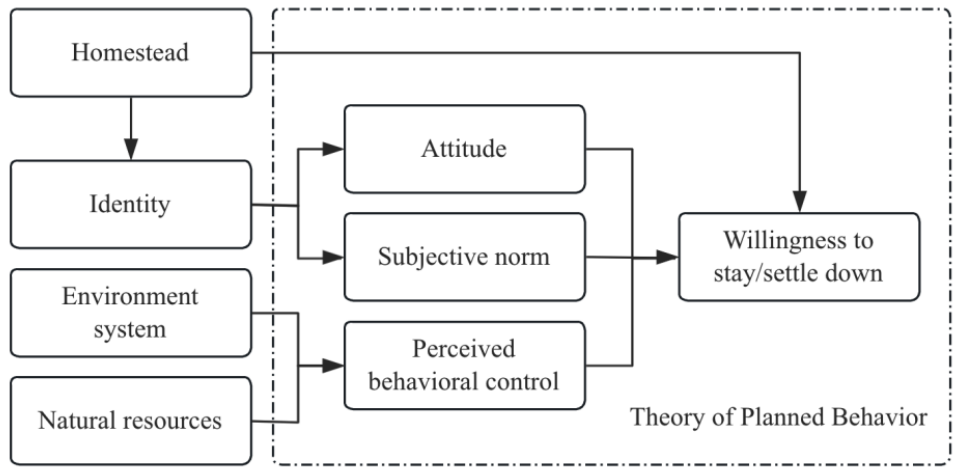
Figure 1. Theoretical analysis framework.